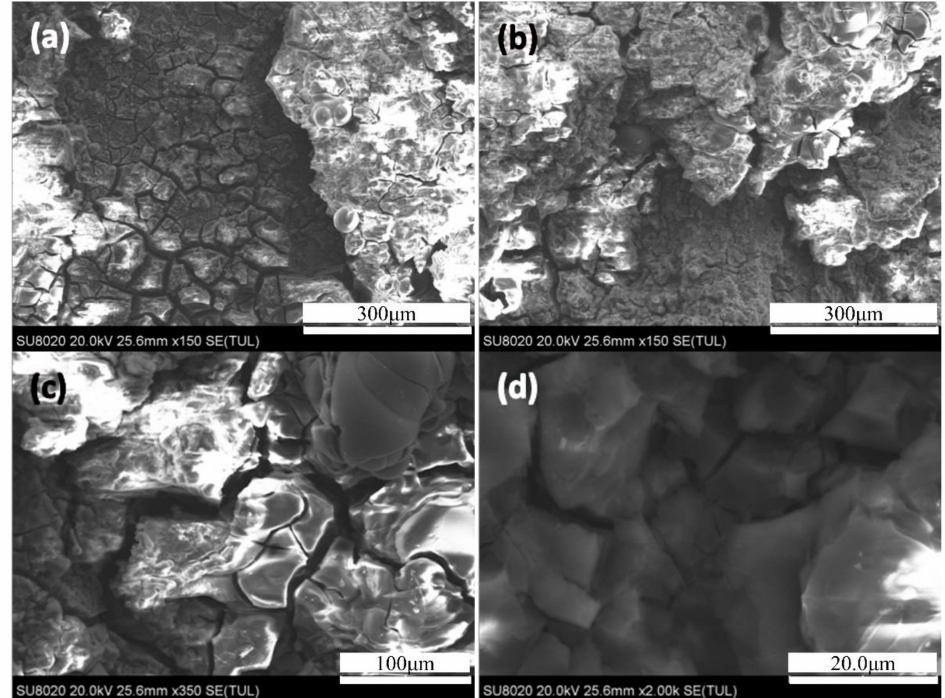
Figure 5. The internal morphology of the 7N01 extrusion aluminum alloy after two-stage aging at infiltrating 24 h: ( a , b ) SEM images under 150 magnification; ( c ) SEM images under 350 magnification; ( d ) cracks in ( a ) under 2k